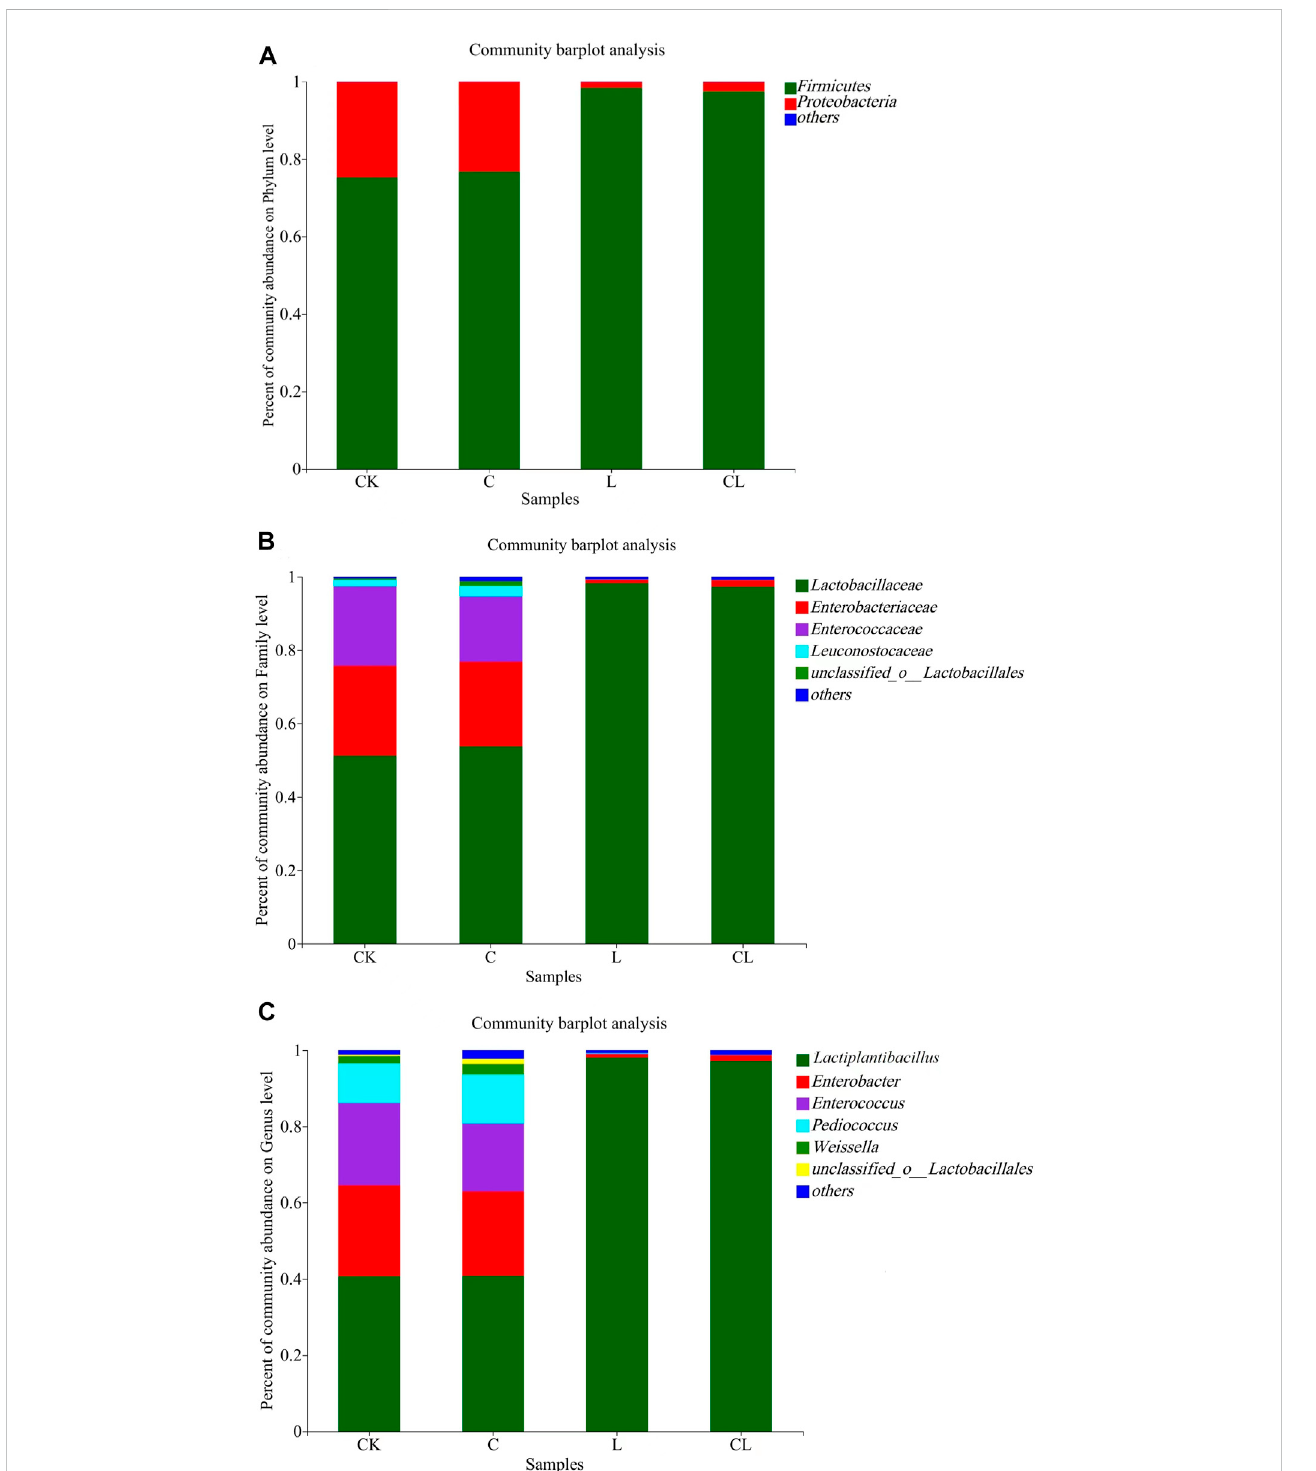
FIGURE 3 (A) Phylum, (B) Family, and (C) Genus-level microbial communities in Caragana korshinskii silage; CK, no additive; C, cellulase; L, Lactiplantibacillus plantarum ( L. plantarum ); and CL, cellulase + L. plantarum